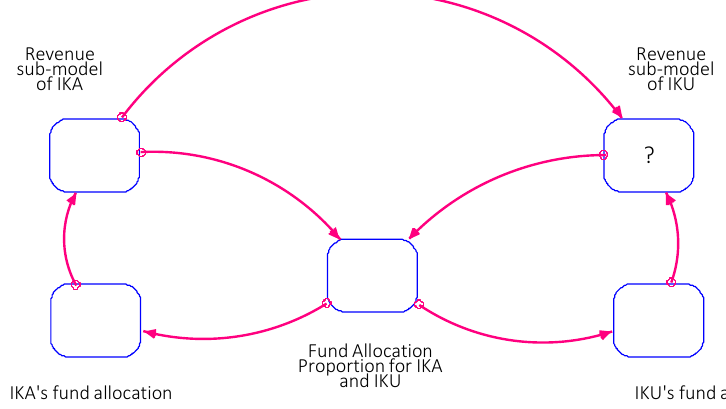
Figure 8. Framework S to S symbiosis effect